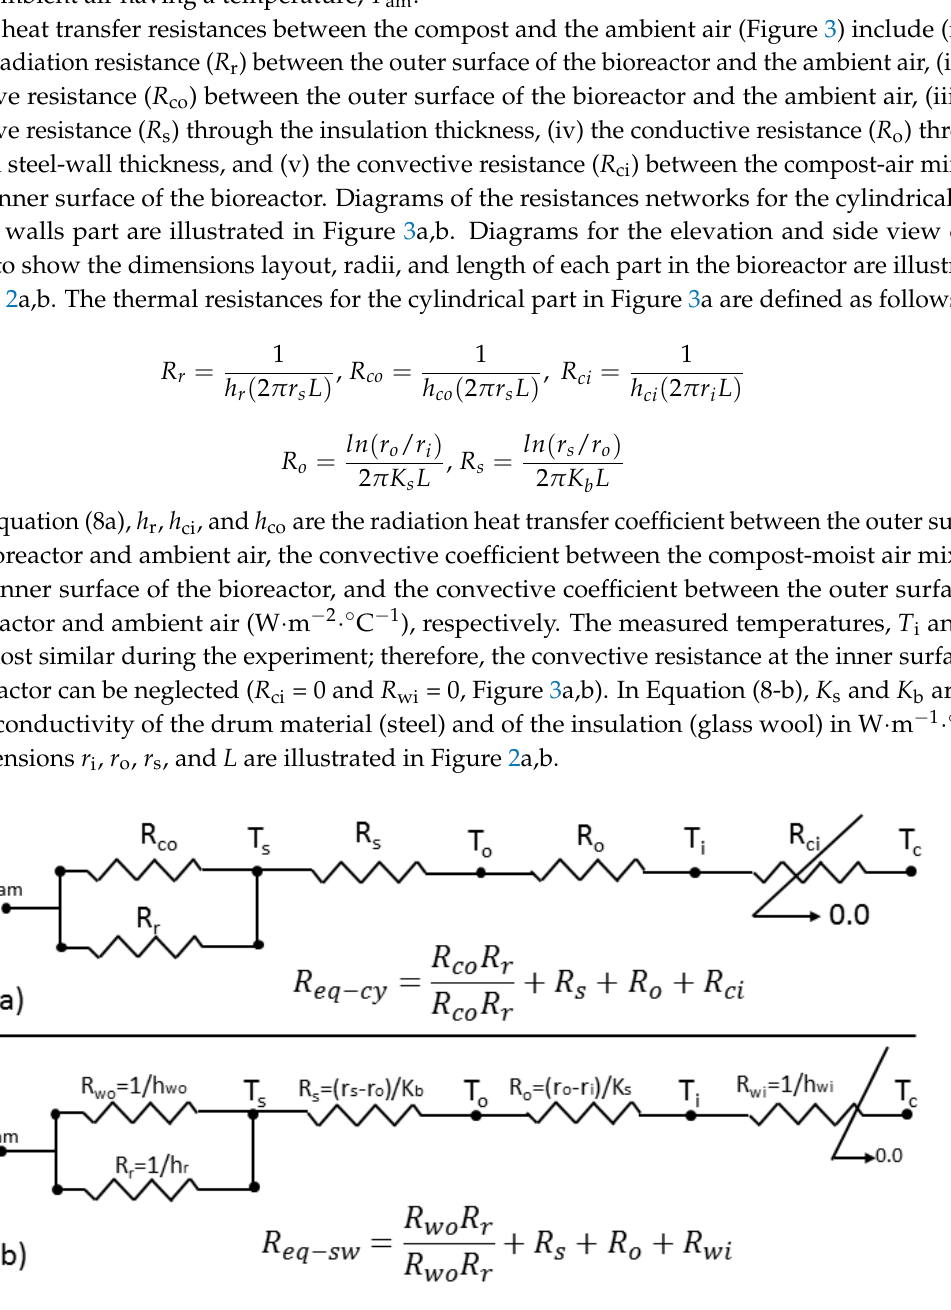
Figure 3. Electrical analogy for the thermal resistances against heat losses transmitted between the compost-moist air mixture and the outside ambient air ( a ) through the cylindrical part and ( b ) through vertical circular side walls.